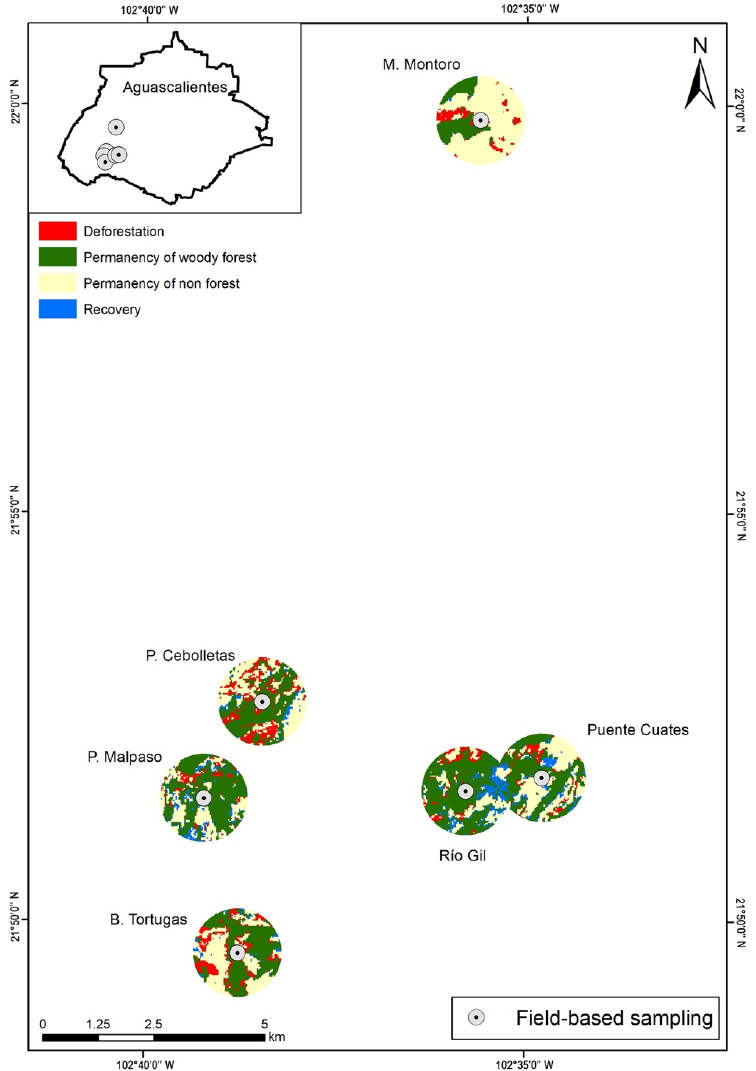
Figure 2. Transition changes of forest cover in buffer zones of 1 km for the period 2003–2013 in the sampling sites in the Aguascalientes State. sampling sites in the Aguascalientes